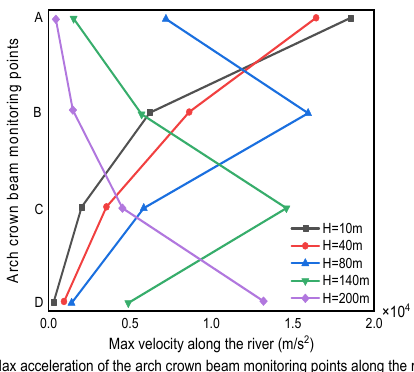
Figure 16. Dynamic response of monitoring points at different detonation depths. The maximum values of displacement, velocity, and acceleration of dam crest monitoring points along the river are shown in Figure 16 to be larger in the middle and smaller on both sides. Furthermore, the greater the detonation depth, the weaker the dynamic response of each dam crest monitoring point. When the detonation depth reaches 200 m, the maximum values of displacement, velocity, and acceleration at the dam crest are approximately 3-, 4-, and 20 times lower, respectively, than when the detonation depth is 10 m. The maximum displacement, velocity, and acceleration values at each monitoring point at the arch crown cantilever position shall be taken as the peak near their respective detonation points, with the force increasing the opening of the detonation depth. When the detonation depth is 10 m, the detonation center is near point A, and the maximum values of displacement, velocity, and acceleration are taken at point A. The detonation center is located between points A and B when the detonation depth is 40 m. As a result, the maximum value of displacement, velocity, and acceleration at monitoring point A is slightly lower than that at detonation depth of 10 m, while the maximum value of displacement, velocity, and acceleration at monitoring point B is slightly higher. When the detonation depth is 80 m, the detonation center is near point B, and the maximum value of each monitoring point’s displacement, velocity, and acceleration is taken at point B. When the detonation depth is 140 m, the detonation center is near point C, and the maximum value of each monitoring point’s displacement, velocity, and acceleration is taken at point C. When the detonation depth is 200 m, the detonation center is near point D, and the maximum value of each monitoring point’s displacement, velocity, and acceleration is taken at point D. This proves that the bang impact load has the most obvious influence on the dynamic response of the monitoring point closest to the detonation center, while the influence on the dynamic response of the monitoring point farthest from the detonation center is relatively weak. The greater the distance, the less powerful the